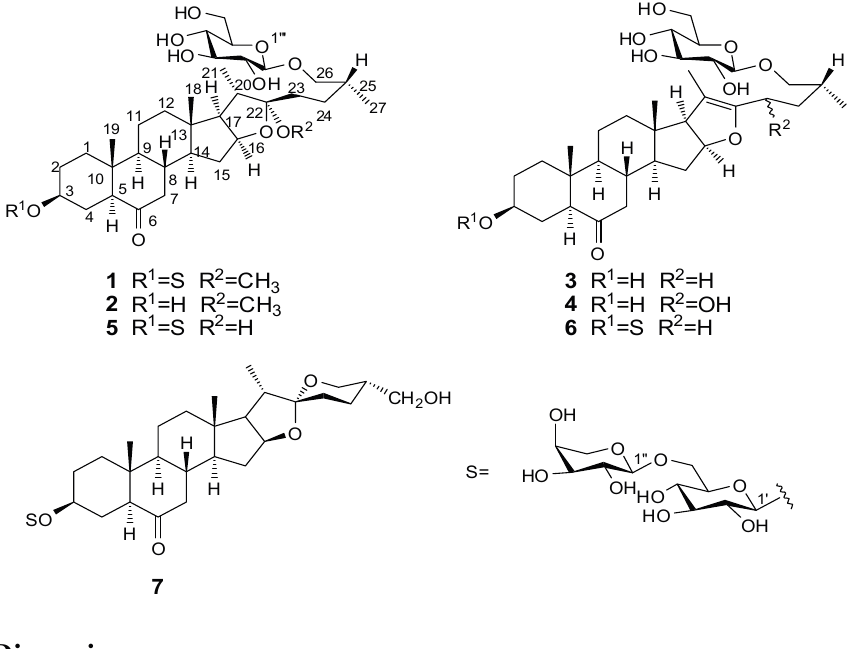
Figure 1. Chemical structure of compounds 1 – 7